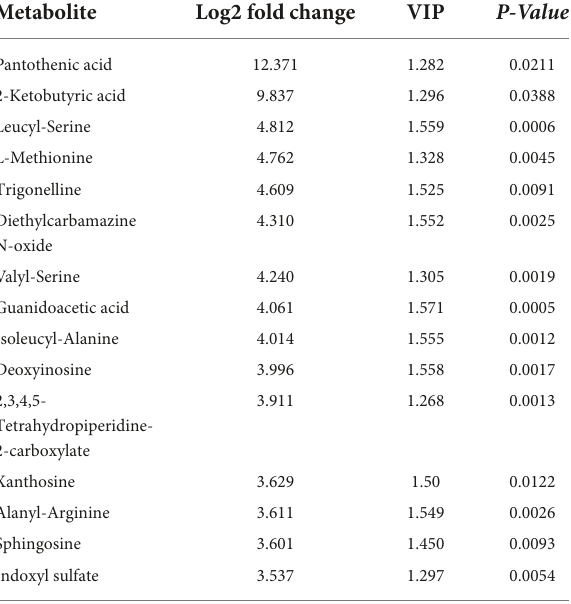
TABLE 2 The top fifteen upregulated differentially expressed metabolites (DEMs).